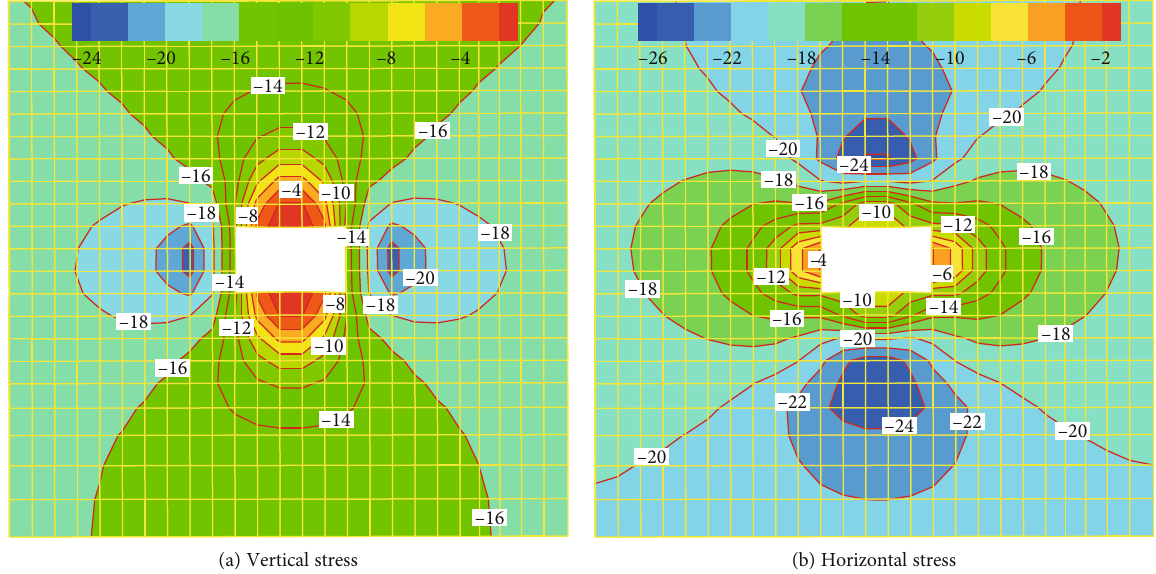
Figure 16: Stress fi eld distribution law of surrounding rock in gas drainage roadway with fl